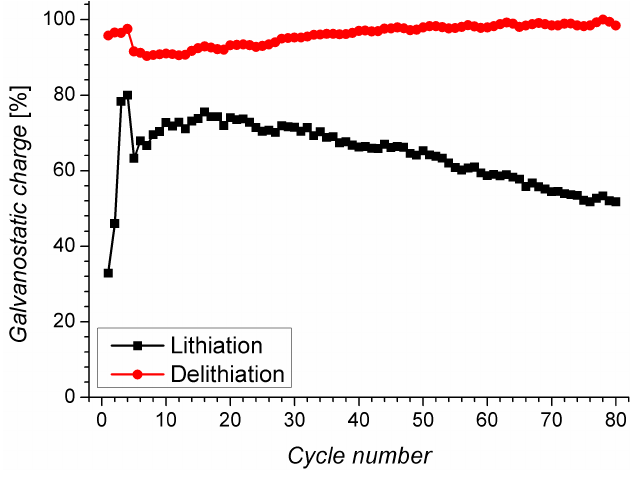
Figure 7. Proportion of the charge obtained under the galvanostatic steps of the test in Figure